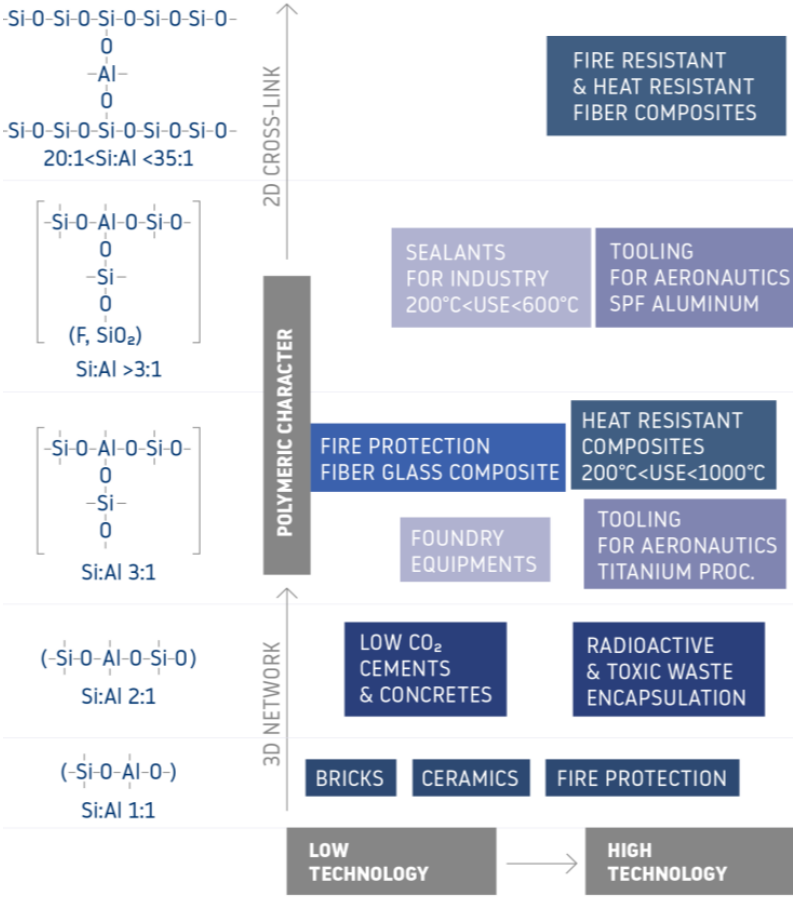
Figure 1. Possible applications of geopolymers depending on the structure (based on [15]). The following materials can be used as foaming agents: aluminum powder, sodium hypochlorite, silica dust, and hydrogen peroxide. These agents react with alkaline activators to create pores in the geopolymer structure [10,12,15]. In the case of aluminum powder, voids are formed according to the following hydrogen release reaction